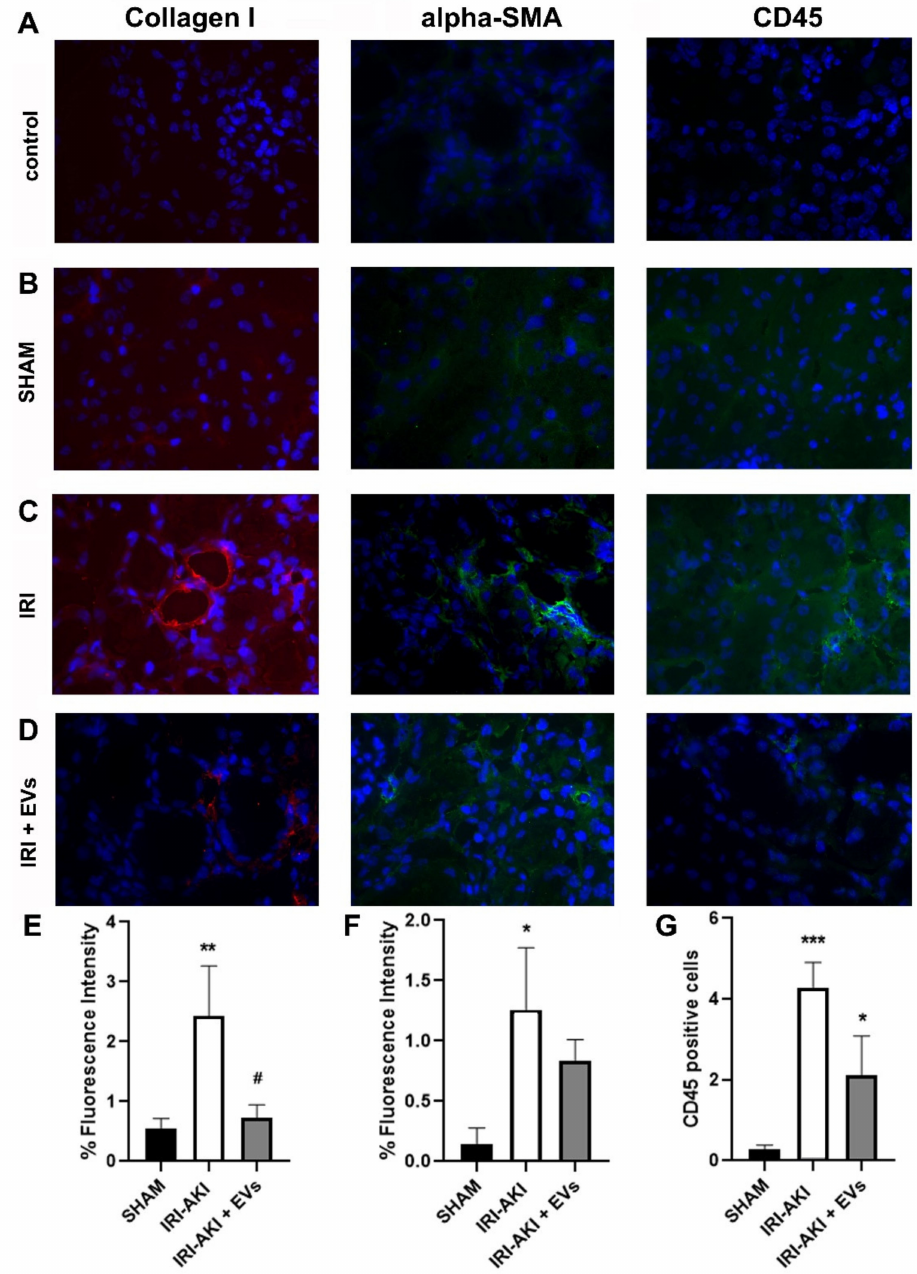
Figure 7. The effect of HLSC-EVs on fibrosis and inflammation in IRI-AKI mice that were sacrificed two days after the surgery. ( A – D ) Kidney cryo-sections from the control (SHAM) mice ( B ),